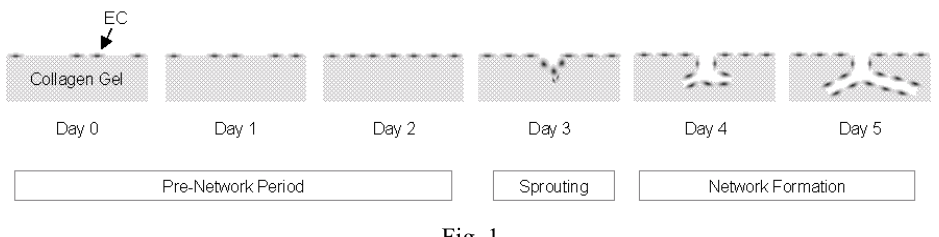
Network formation process in the gel-bFGF model and medium-bFGF model. ECs reached confluence on the surface of collagen gel by day 2, then invaded the gel (after day 3), and finally formed networks (day 5).